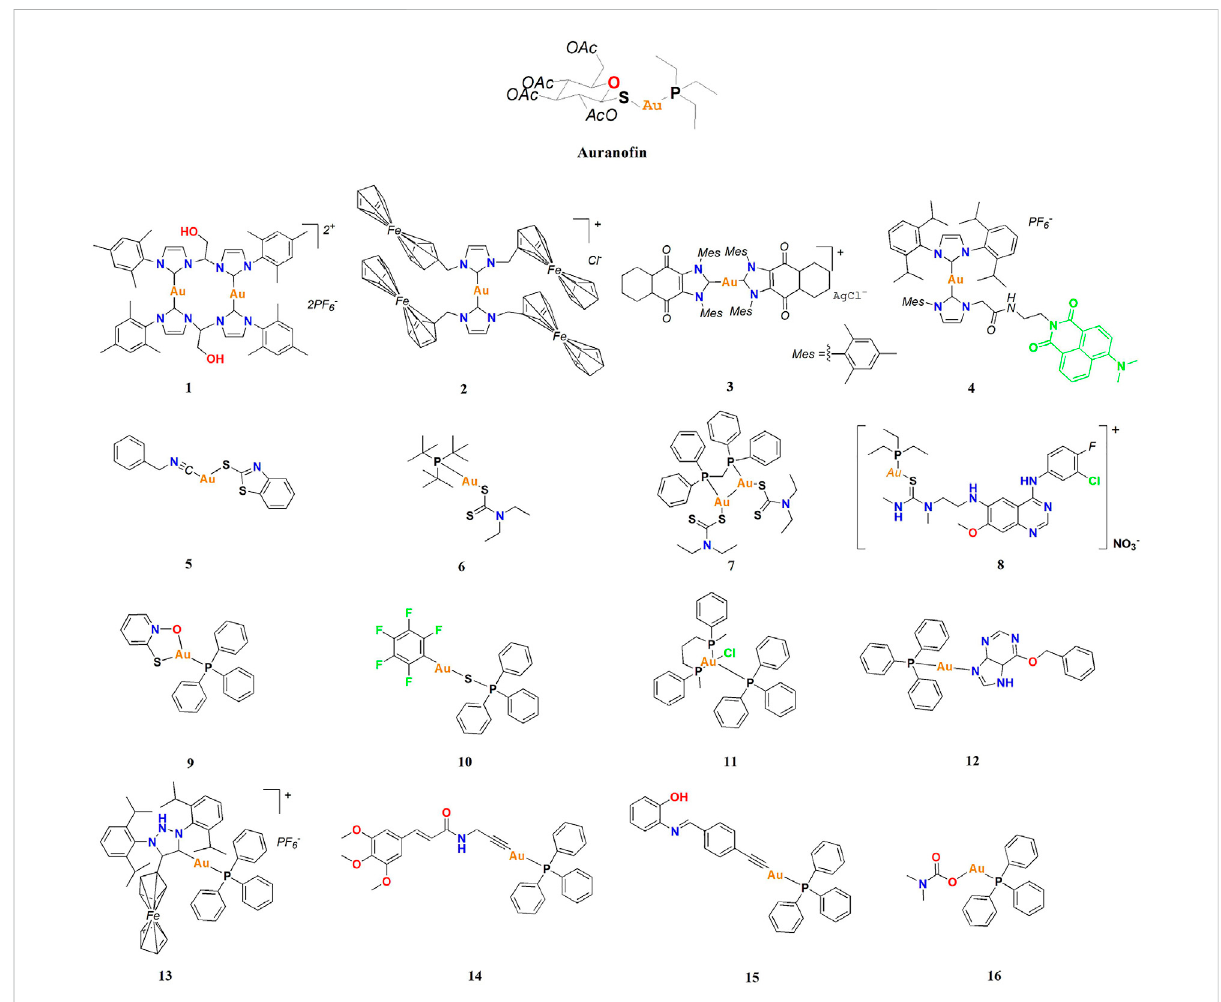
FIGURE 1 Anti-lung cancer gold(I)